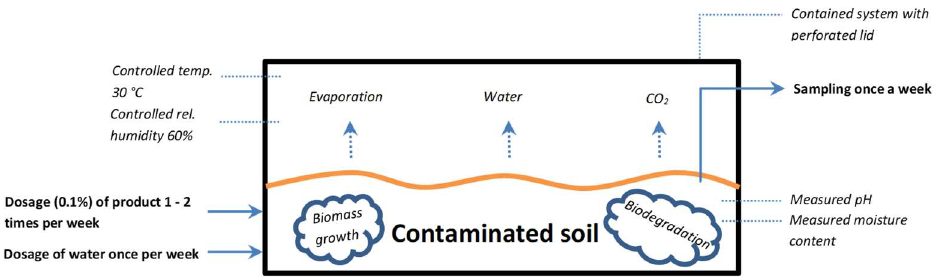
Figure 2. Diagrammatic representation of test system.